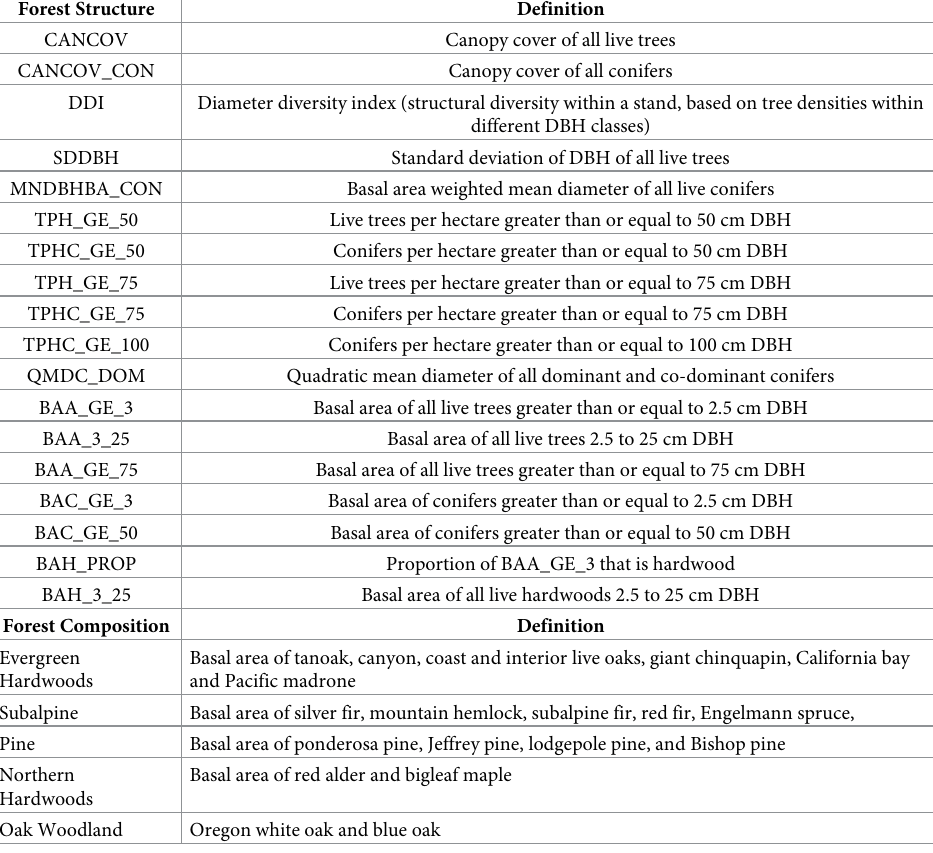
Table 2. List of variables used for modeling relative habitat suitability of northern spotted owl site centers. Forest